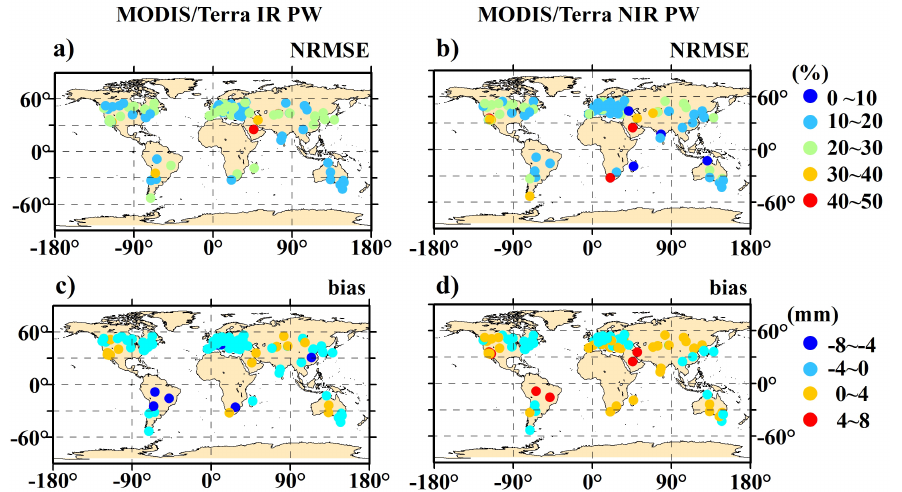
Figure 3. Statistics of the normalized root mean square error (NRMSE, %) and bias (mm) at the global International GNSS Service (IGS) stations for ( a , c ) MODIS IR PW and ( b , d ) MODIS NIR PW over the land at 60 ◦ S–60 ◦